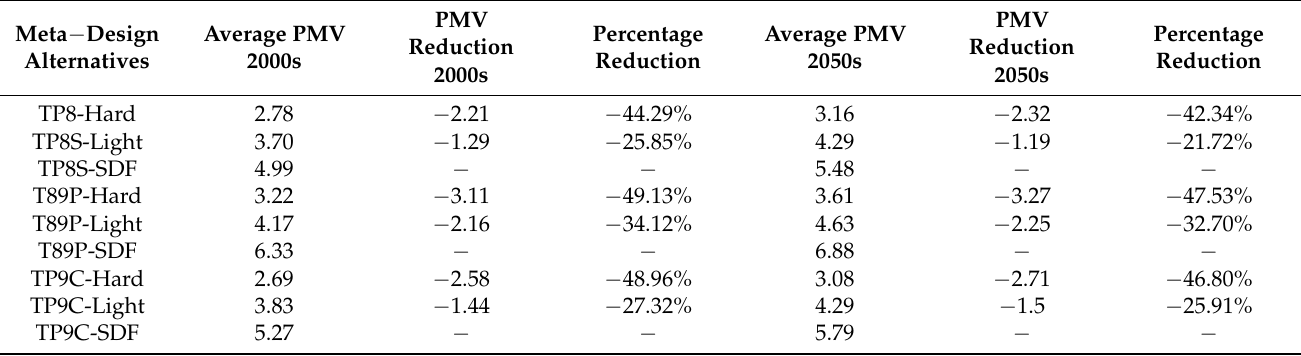
Table 4. Comparison of PMV average values: absolute reduction and percentage.